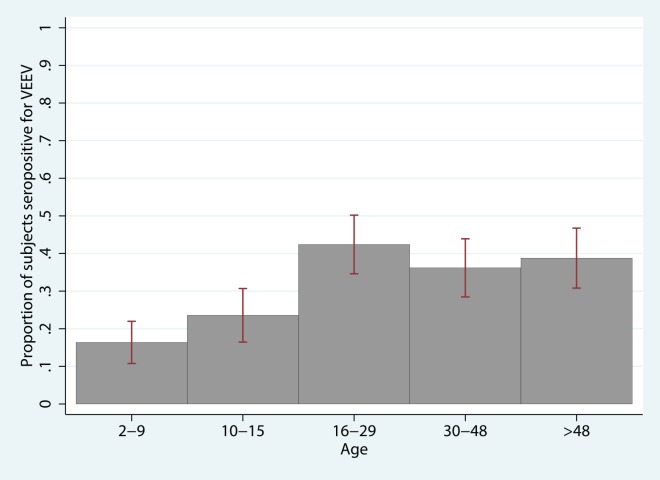
Age structure of MADV seroprevalence.Table displays odds ratios, 95% confidence interval, and p-value for univariate logistic regression of MADV seropositivity with each unit increase in age (unit = one year).